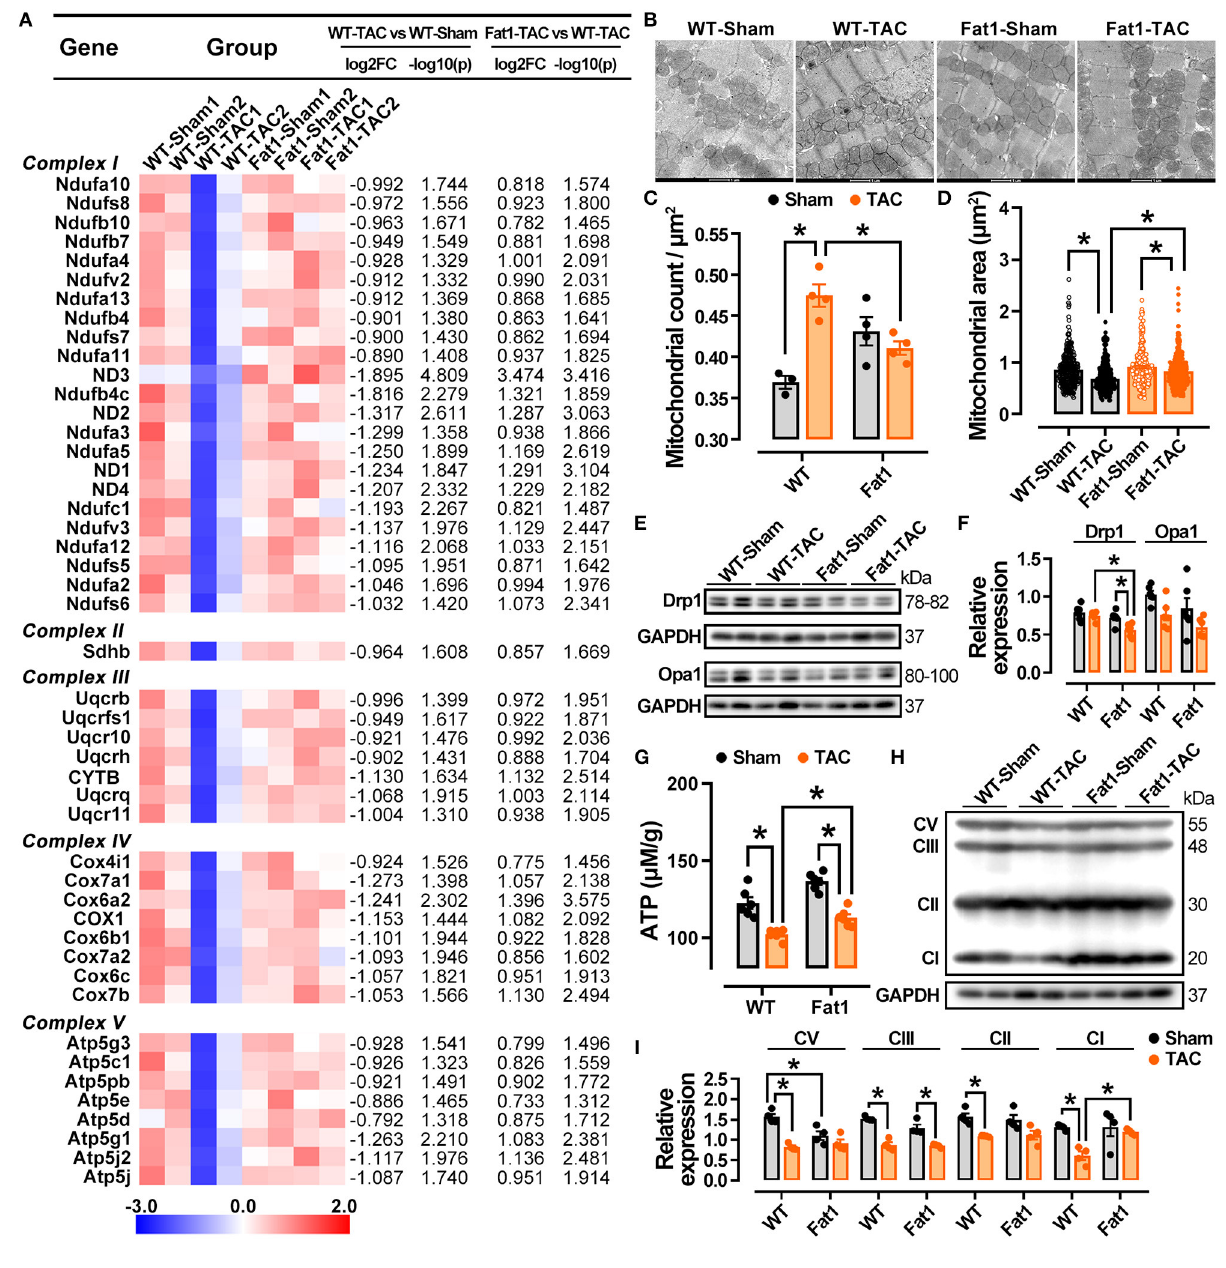
FIGURE 8 | Preservation of mitochondria function by fat-1 transgene in pressure overload hearts. In the RNA-sequencing datasets of experimental groups, 47 genes encoding oxidative phosphorylation markers, mitochondrial respiratory chain complexes were showed (A) . Under transmission electron microscopy, the mitochondria display a reduction in size and increase in counts per square µ m in WT-TAC hearts, whereas those of Fat1-TAC hearts were not altered by pressure overload (B–D) , N = 300 mitochondria in the measurement area. The fission marker Drp1 was significantly reduced in Fat-1 TAC hearts but not in the dilated WT-TAC heart (E,F) . ATP generation was restored by endogenous n-3 PUFAs under pressure overload conditions (G) . The protein expression of respiratory chain complexes was downregulated in the dilated WT-TAC hearts. Compared to the sham hearts, pressure overload did not suppress the expression levels of mitochondrial complexes I, II, V in fat-1 transgenic hearts (H,I) . N = 4 for each group. * P <